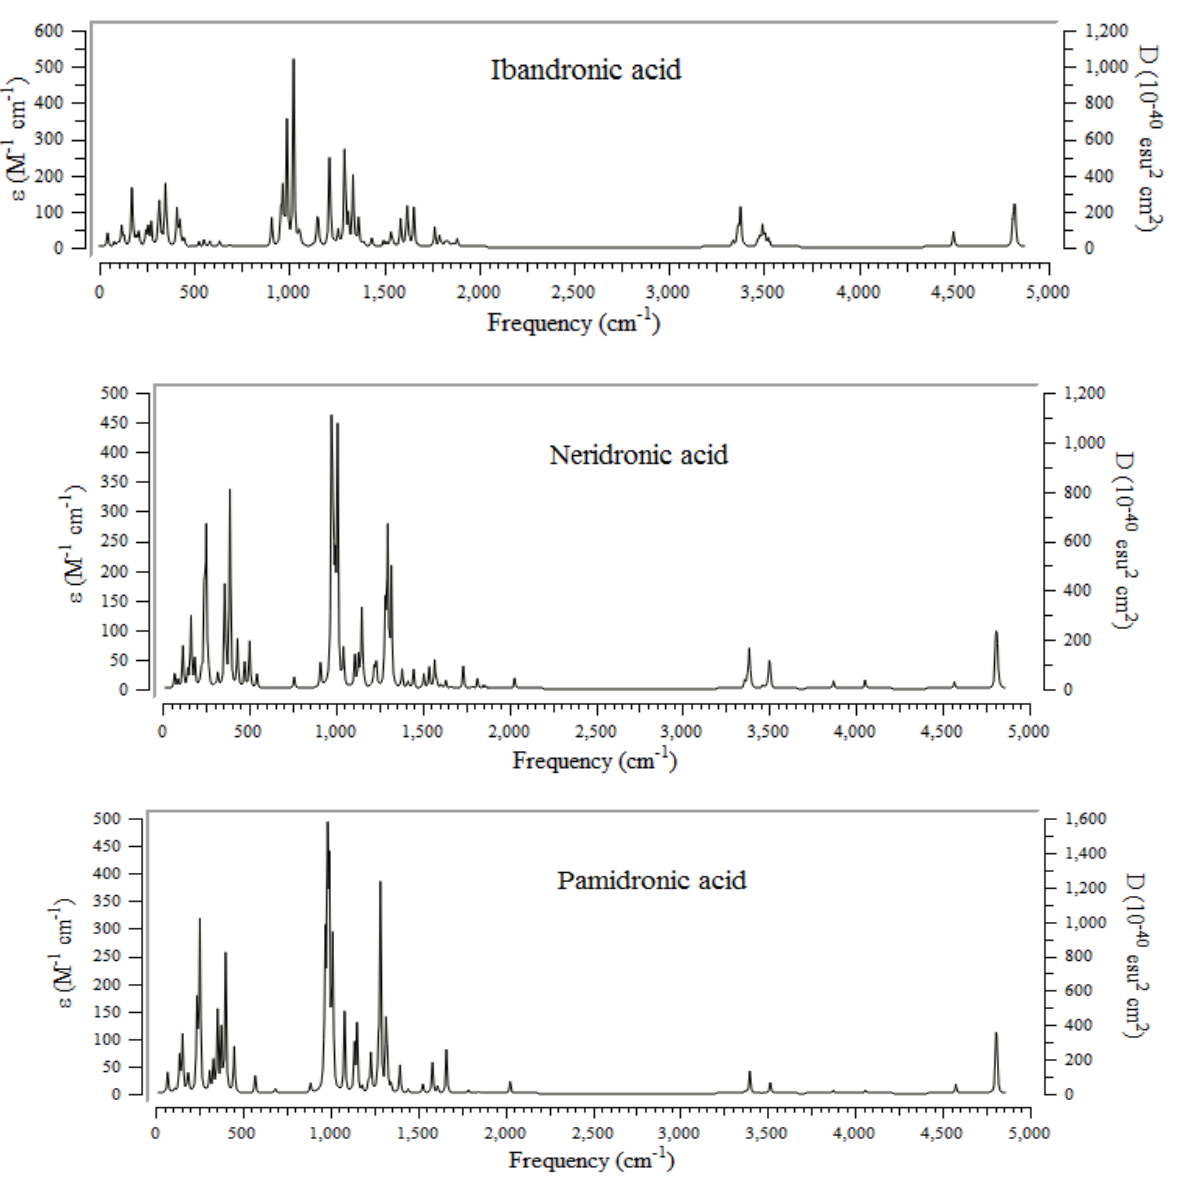
Figure 3. Computed IR spectra for alendronic acid, ibandronic acid, neridronic acid, and pamidronic acid of BPs conjugated onto (6, 6) armchair CNT using 6-311+G (2d,p) calculations. Therefore, the physico-chemical properties of the relative harmonic frequencies, IR intensities, dipole moment, virial coefficient (-V/T), and ∆H, ∆G, and ∆S have determined the stability of BPs among [alendronic acid, ibandronic acid, neridronic acid, pamidronic acid -Mn 2+ , Fe 2+ , Co 2+ ] complexes conjugated on the surface of the (6, 6) armchair CNT as drugs for bone disorder treatment (Table 2). These nanostructures have proved the characteristics of the chelated bonding with transition metal cations of Mn 2+ , Fe 2+ , and Co 2+ using the drug delivery method (Table 2). Table 2. Calculated functions of harmonic frequencies (cm − 1 ); IR intensities (km/mol) in different normal modes; thermodynamic properties of ∆G and ∆H in kcal/mol , and ∆S in cal/mol.K −1 at 300K; and optimized dipole moment (Debye).